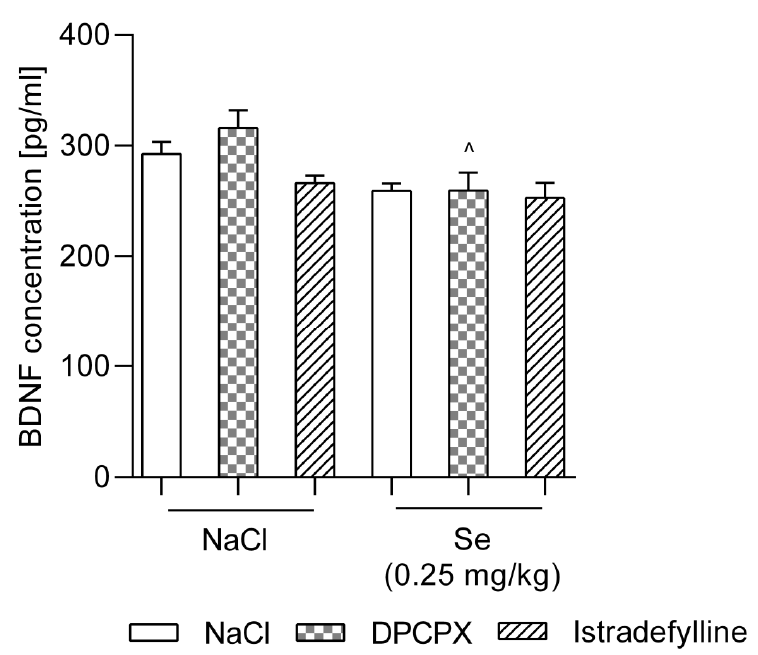
Figure 3. Effect of combined administration of sodium selenite, and selective adenosine receptor antagonists on the BDNF level in murine serum. DPCPX, sodium selenite (Se), and NaCl 0.9% were administered i.p. 30 min, while IST was administered p.o. 60 min prior behavioral testing. Data are presented as the means ± SEM. Each experimental group consisted of 8–10 mice. ^ p < 0.01 vs. DPCPX (two-way ANOVA followed by Bonferroni’s post hoc